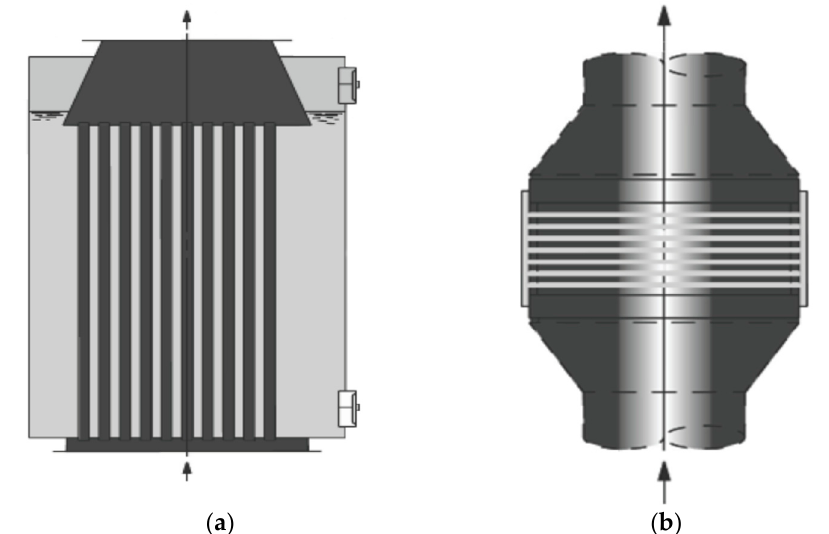
Figure 1. Exhaust gas boiler types [1]: ( a ) vertical smoke tubes; ( b ) horizontal water tubes.